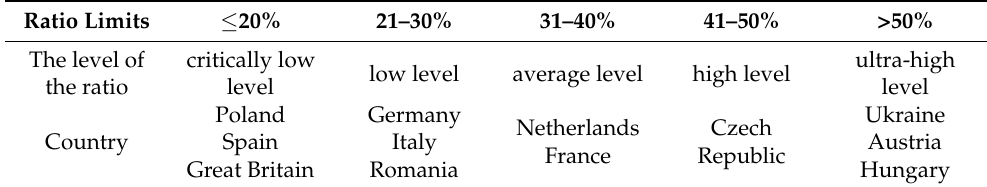
Table 10. Levels of supply of countries with underground gas storage facilities. Ratio Limits ≤